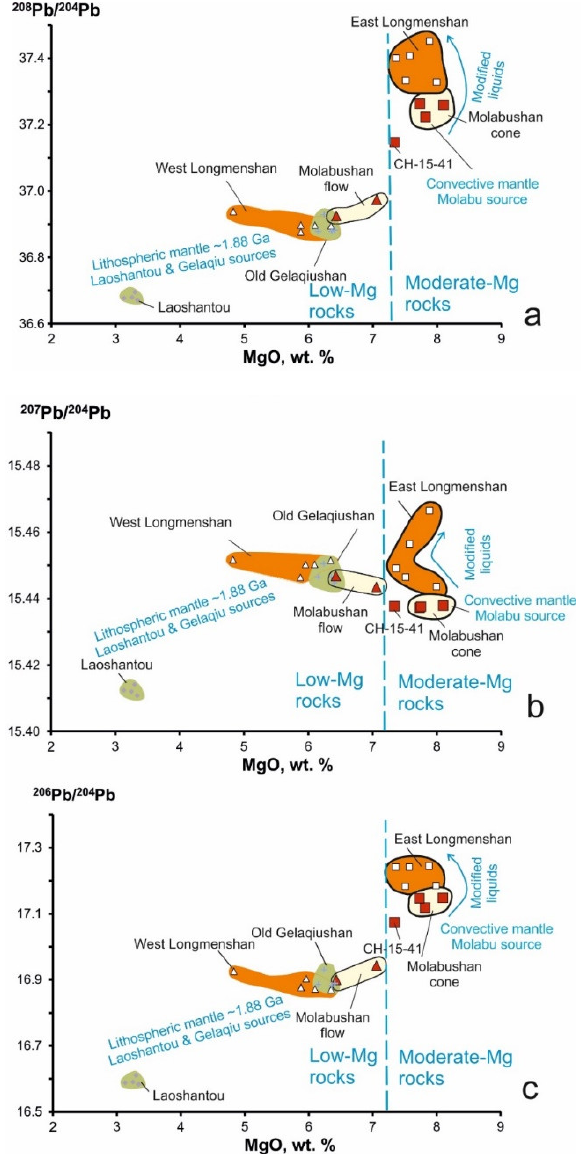
Figure 9. Pb isotopic ratios versus MgO diagrams, ( a ) 208 Pb / 204 Pb ratios; ( b ) 207 Pb / 204 Pb ratios; ( c ) 206 Pb / 204 Pb ratios. Symbols are as in Figure